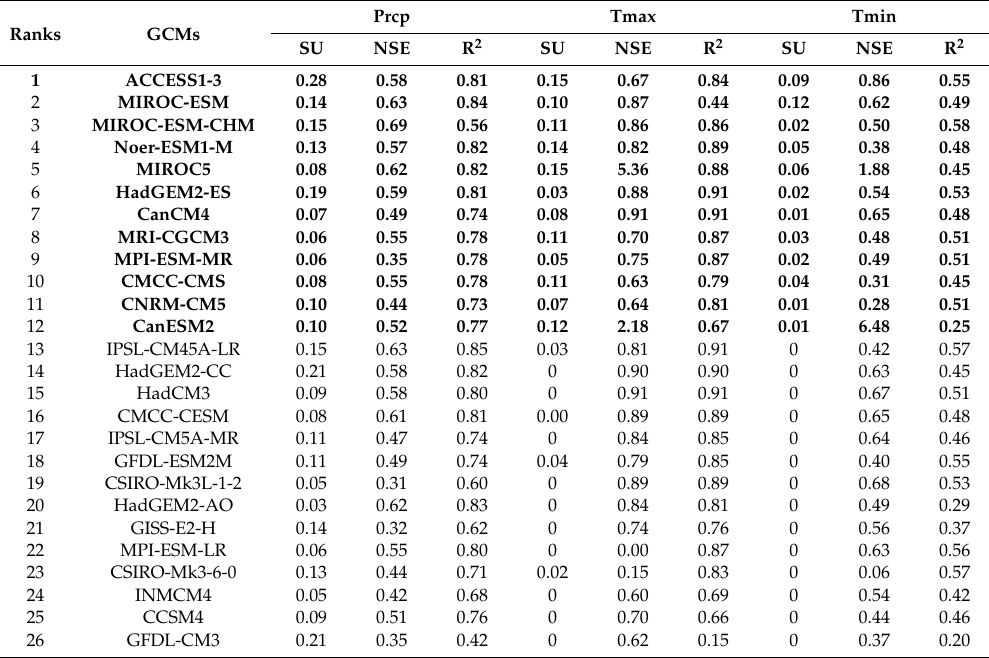
Table 2. Overall SU weights of GCMs and their ranks according to their ability to simulate the CRU prcp, Tmax, and Tmin datasets. The selected GCMs are shown in bold font.